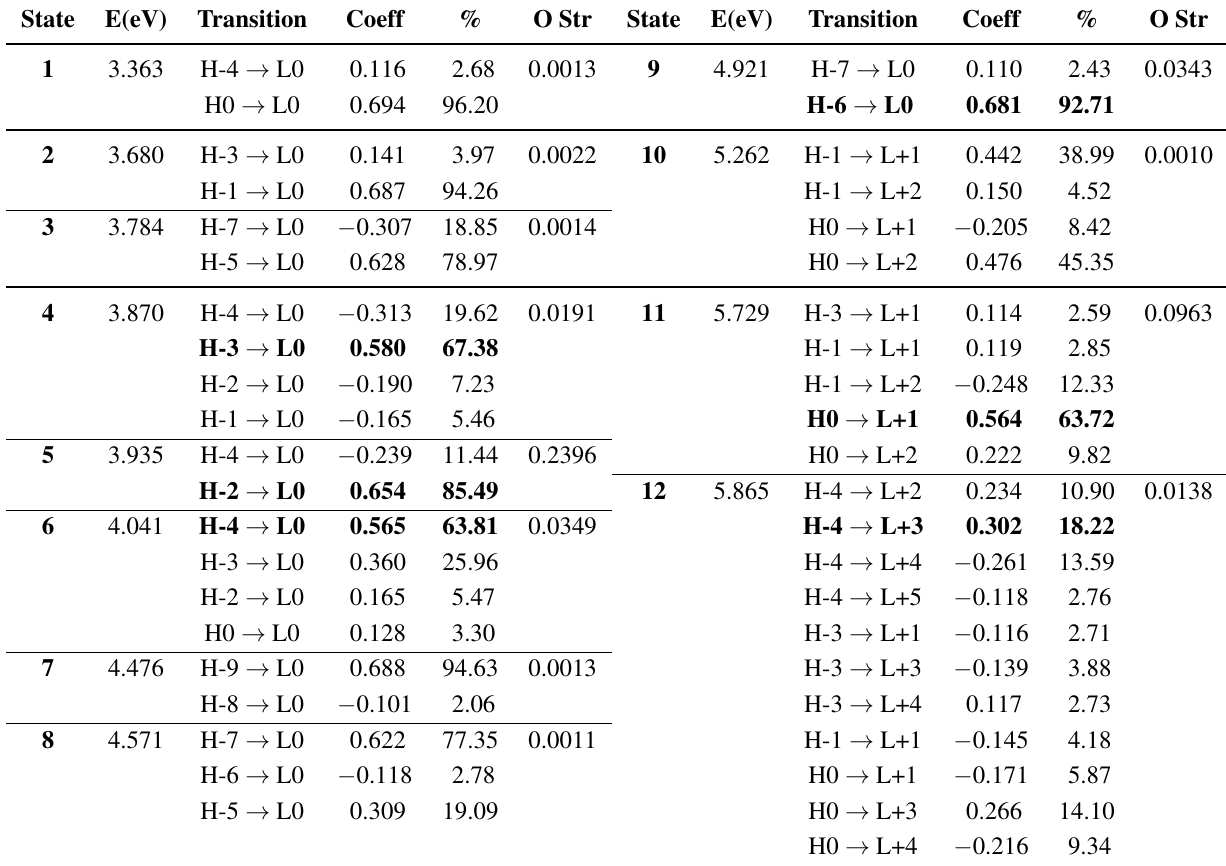
Table 1. TD-DFT calculated states and electronic transitions which rule the UV-vis optical absorption of benznidazole in water (PCM